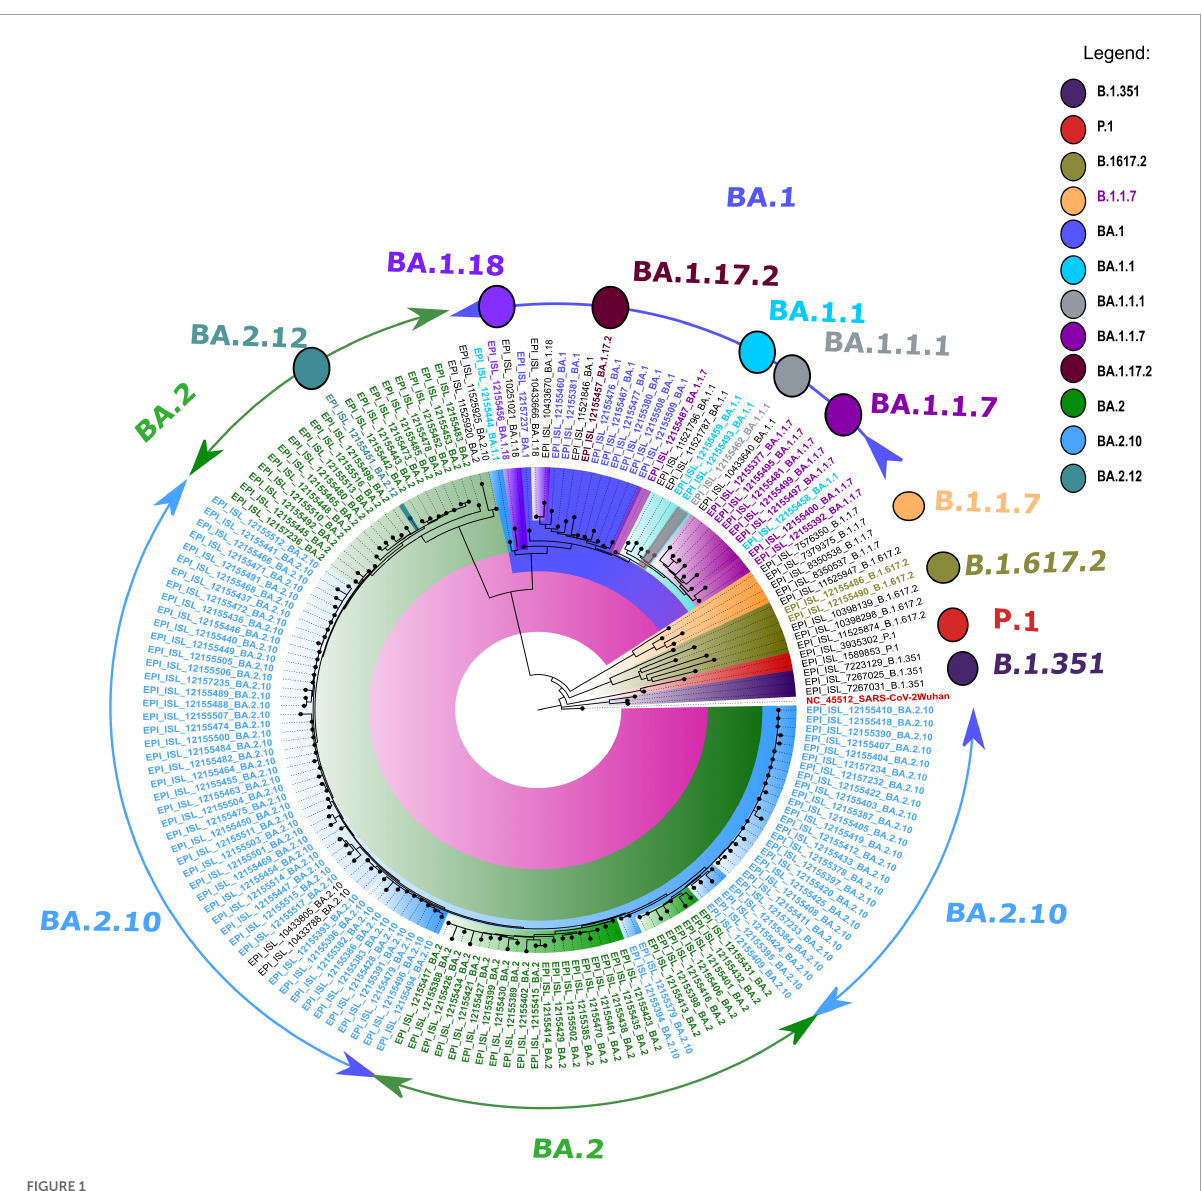
FIGURE1 A neighbor-joining (NJ) tree from severe acute respiratory syndrome coronavirus 2 (SARS-CoV-2) sequences was generated using a Tamura 3-parameter model with gamma distribution and a bootstrap replication of 1,000 cycles. The whole-genome sequences of other SARS-CoV-2 variants deposited in GISAID used in this study are marked in black, and the reference isolate of Wuhan-HU-1 (accession no: NC 045512) is marked in red